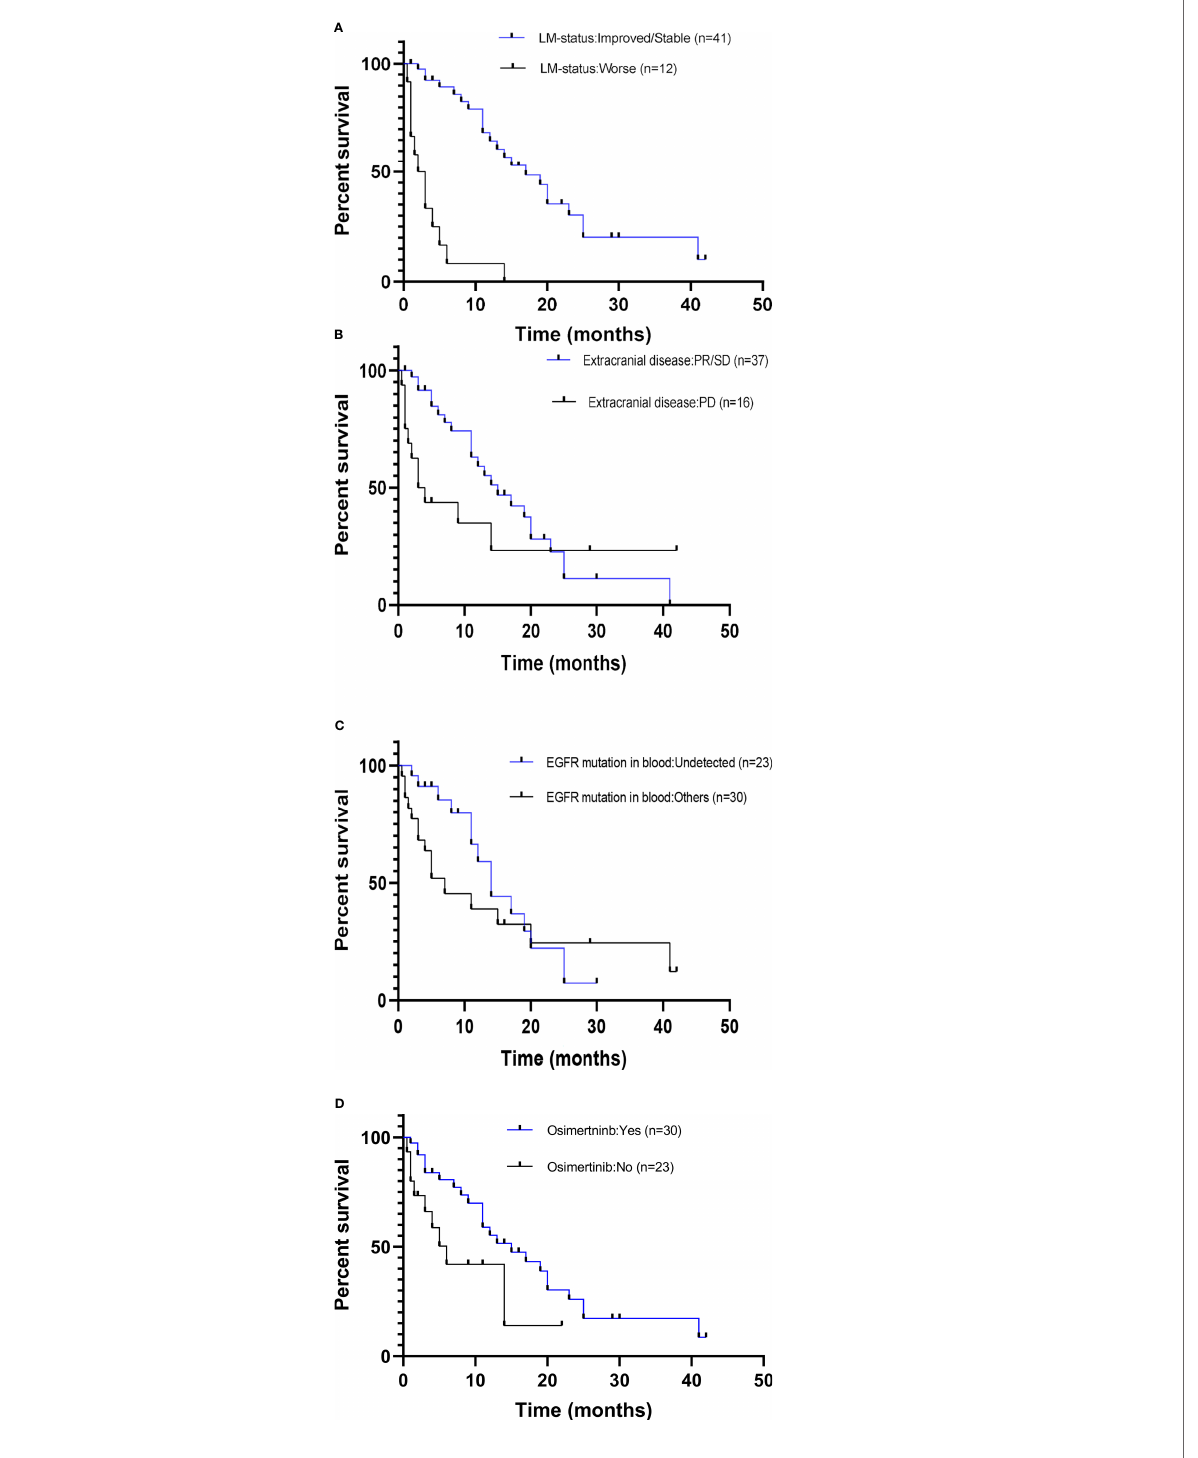
FIGURE 4 | Comparison of overall survival curves for subgroups of patients with EGFR -mutated advanced NSCLC with leptomeningeal metastasis (LM). Patients included in this study were subgrouped according to (A) LM disease control status (PR/SD vs . PD). (B) Disease control status of the extracranial metastasis prior to diagnosis with LM (PR/SD vs . PD). (C) EGFR mutation status in the blood at LM diagnosis (positive vs . undetected). (D) Treatment received following diagnosis with LM (osimertinib vs . previous generations EGFR TKI/no treatment). NSCLC, non-small cell lung cancer; PR, partial response; SD, stable disease; PD, progressive disease; EGFR, epidermal growth factor receptor; TKI, tyrosine kinase